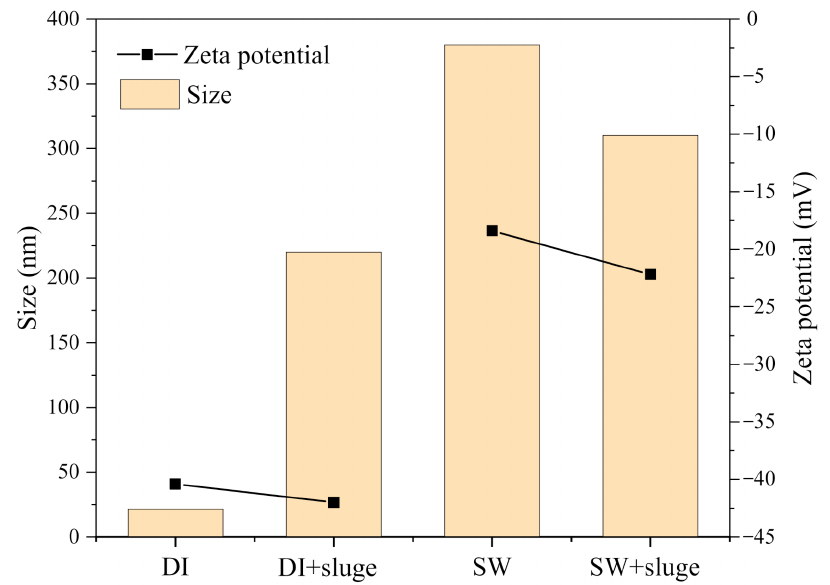
Figure 10. The effect of sludge addition on the size and ζ − potential changes in DI − and SW − diluted cit − AgNPs (50 × dilution, 1.7 × 10 10 particles mL − 1 , 1.68 mg L − 1 ). Note: HA in sludge was 42 mg L − 1